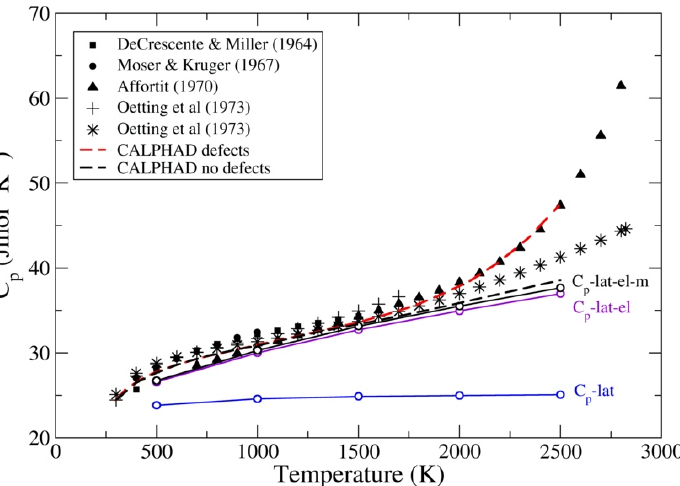
Figure 6. Specific heat at constant pressure, C p , for UC. Levels of theory are open circles, where the connecting lines are guides for the eye only. Solid symbols are experimental data from [63–66] and CALPHAD results are dashed lines.